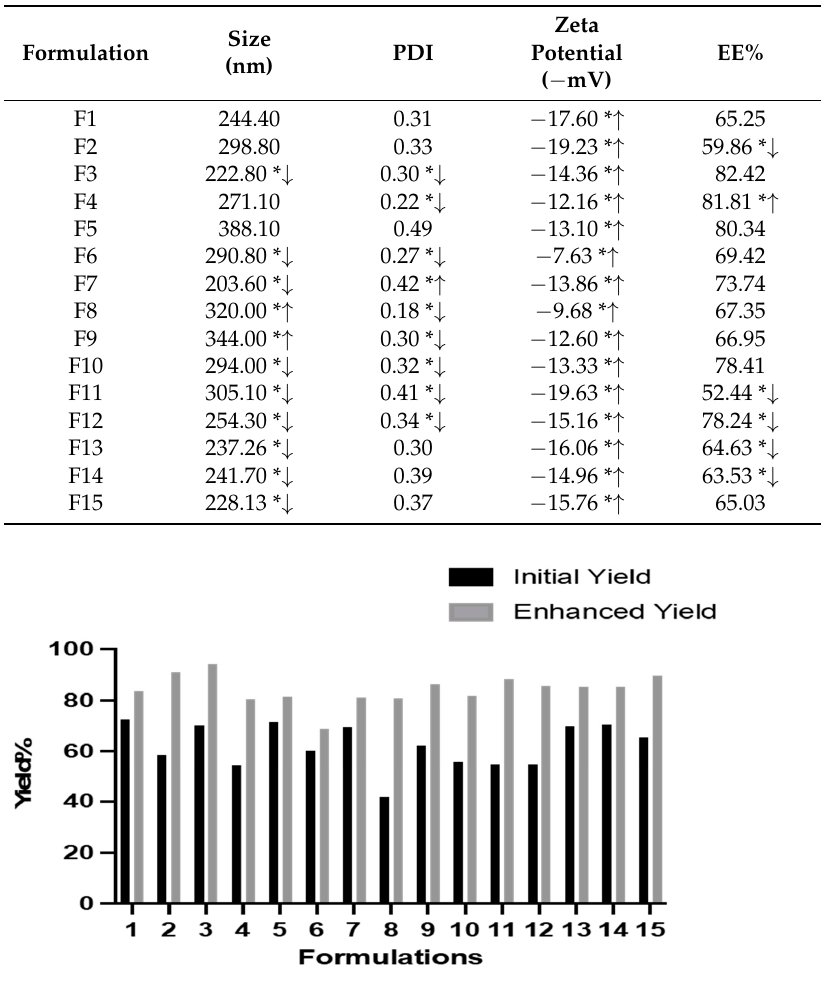
Figure 1. Initial and enhanced yield percentage of NP formulations.